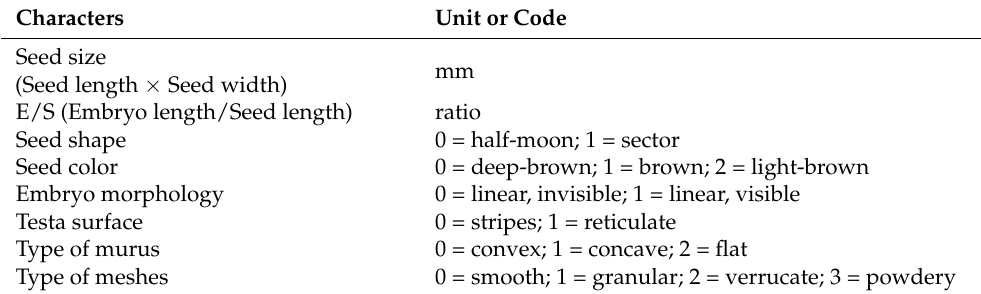
Table 2. The seed characters used in cluster